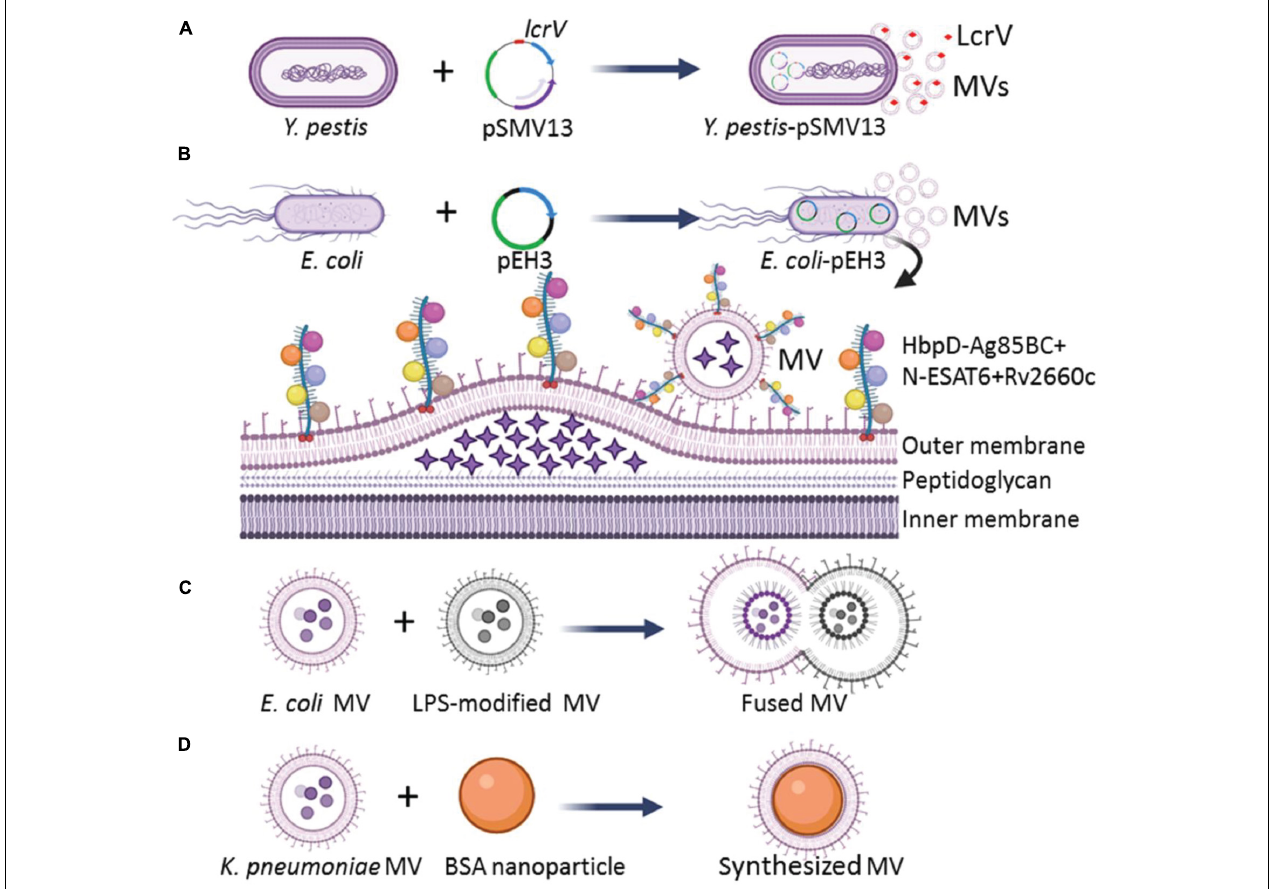
FIGURE 1 | Strategies for engineering of bacterial MVs with enhanced immunogenicity. (A) Engineering Y. pestis by transformation of an Asd + plasmid pSMV13 to express antigen LcrV, and MVs produced by the engineered Y. pestis loaded more LcrV than those derived from the wild-type strain. (B) E. coli transformed with a recombinant plasmid pEH3 to express HbpD + M. tuberculosis Ag85B C + N -ESAT6 + Rv2660c chimeric antigens, and the expressed HbpD-Ag85B C + N -ESAT6-Rv2660c chimeric antigen could be effectively integrated into the MVs. The asterisks in the lumen of MVs represent bacterial proteins. (C) The MVs with enhanced immunogenicity could be prepared in vitro by the aggregation and fusion of MVs derived from different bacterial strains or species. The circle dots colored with diverse blue in the lumen of MVs represent bacterial proteins, DNA, and RNA. (D) Larger MVs could be constructed by depositing of MVs onto BSA